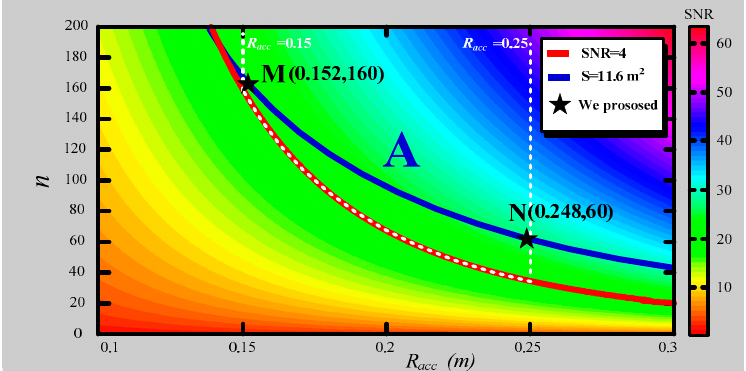
Figure 8. Two-dimensional image of Figure 7.